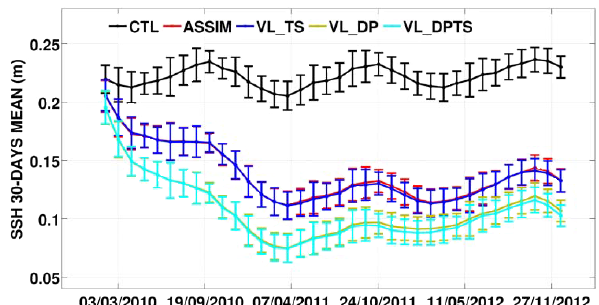
Figure 12. 30-day running SSH mean (m) of the control run (black) and the prior state of the experiment ASSIM (red), VL_TS (dark blue), VL_DP (dark yellow) and VL_DPTS (light blue) from 1 Jan- uary 2010 to 31 December 2012. The markers represent the 30-day running mean values of SSH, while the bars correspond to the stan- dard deviations of each